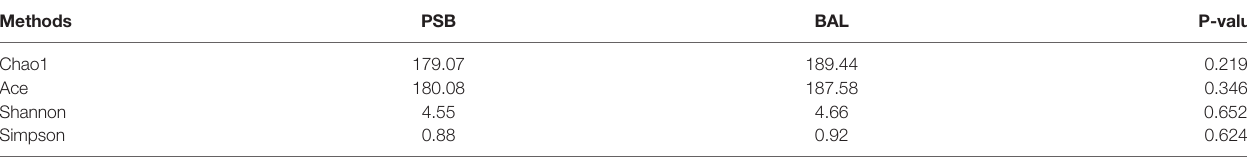
TABLE 2 | Alpha diversity analysis and statistical analysis.